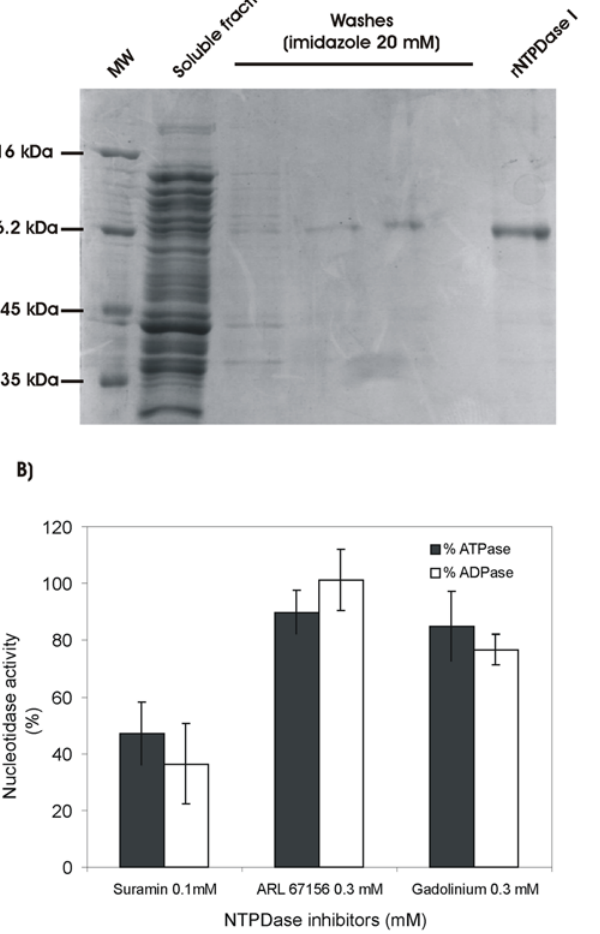
Figure 5. Heterologous expression of T.cruzi Ecto-NTPDase-1 and the effect of ecto-ATPase inhibitors on purified protein. A) SDS-PAGE stained with coomassie blue. A 15 m L sample of each step of production and purification of Ecto-NTPDase-1 was applied in each lane, showing the purified protein with approx. 66 kDa. MW, molecular weight markers. B) ATPDase activity of purified Ecto-NTPDase-1 in the presence of ecto-ATPase inhibitors. The results represent the percent activity with inhibitor related to the activities in the absence of inhibitors. Data are mean 6 SE of two independent experiments, each assayed in